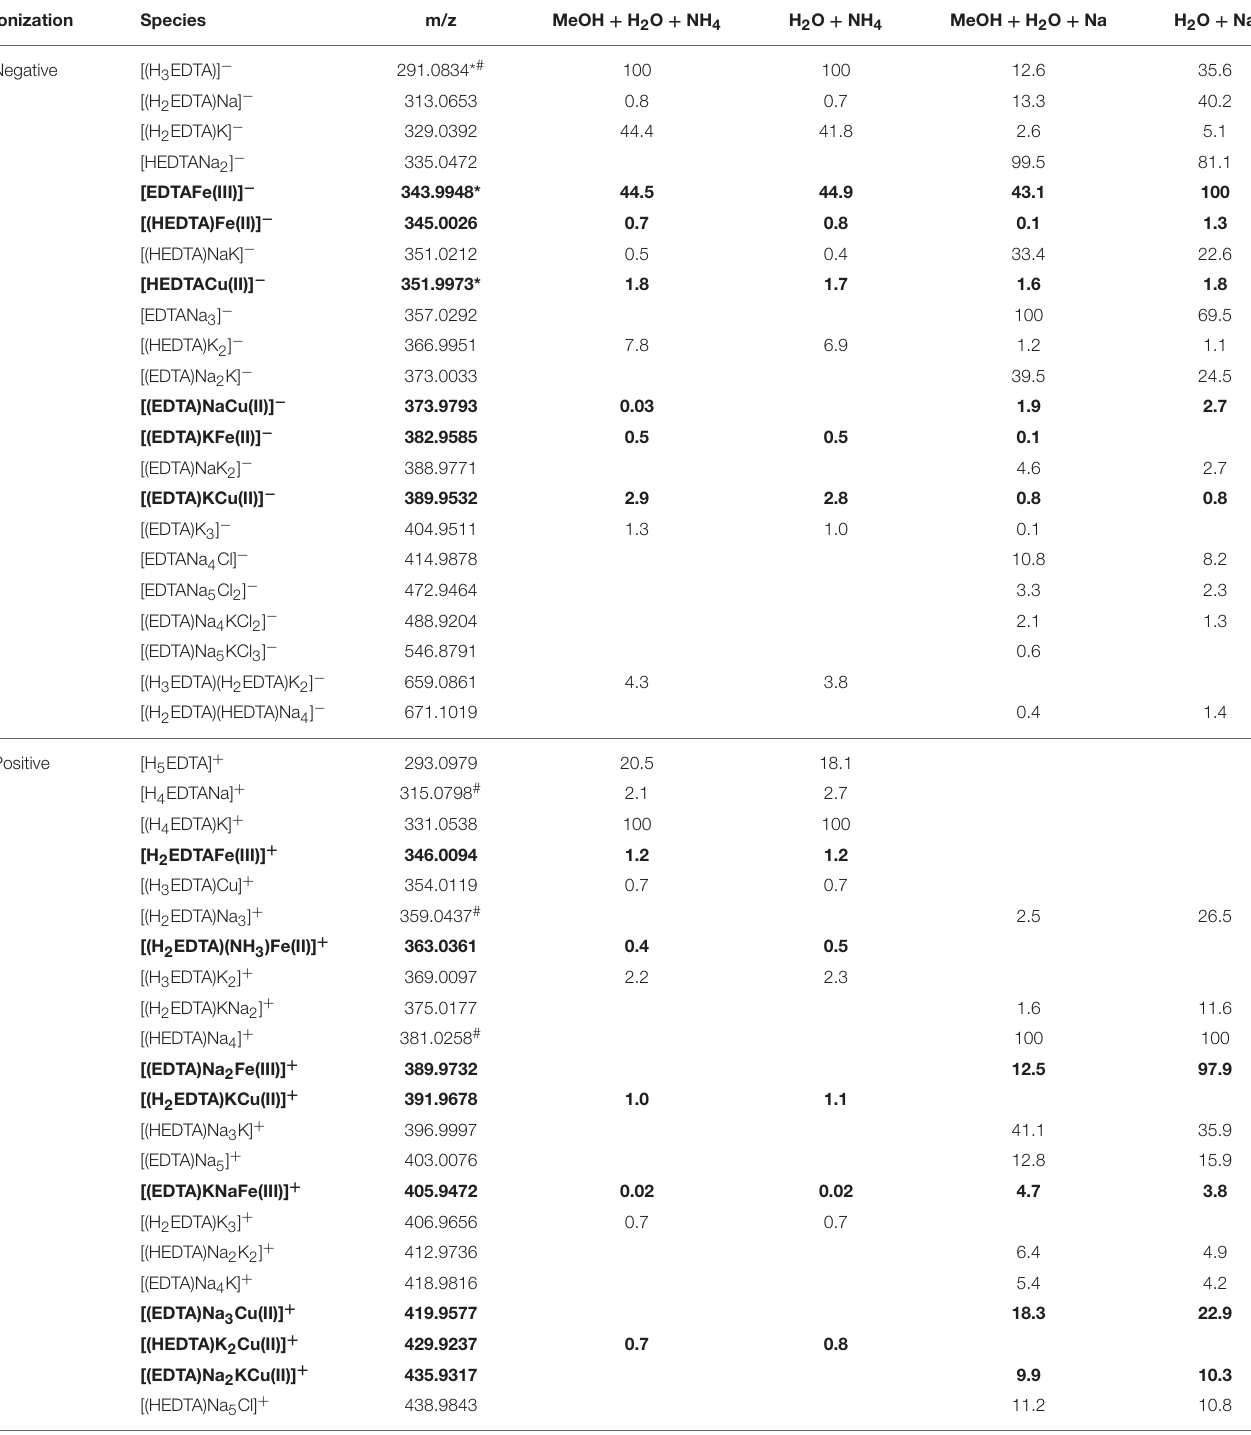
TABLE 3 | Detected EDTA and EDTA ± Fe ± Cu species (bold) in the four analytical setups at the FT-ICR-MS. Ionization